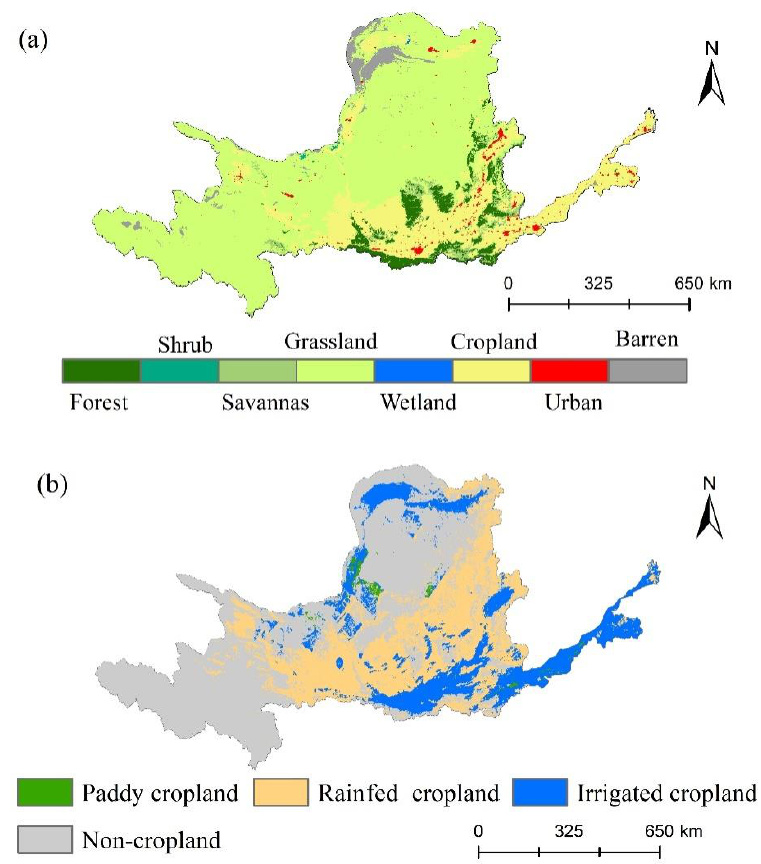
Figure A1. Spatial distribution of the ( a ) land type and ( b ) rainfed, irrigated, and paddy cropland during 2003–2015. Data regarding rainfed, irrigated, and paddy cropland distribution are from Salmon et al. (2015). Data regarding the spatial distribution of land type are from the MODIS land use / land type product of MCD12Q1 version 6 (V6), which can be download from https: // ladsweb.modaps.eosdis. nasa.gov. We classified 17 categories into eight broad